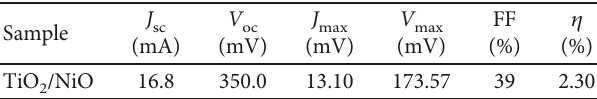
Figure 8: Typical I - V curve for the prepared TiO heterojunction thin- fi lm solar cell under illumination and in the dark. Table 2: Solar cell parameters of the fabricated solar cell.